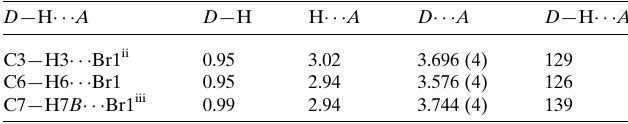
Table 4 Hydrogen-bond geometry (A˚ , (cid:4) ) for II .